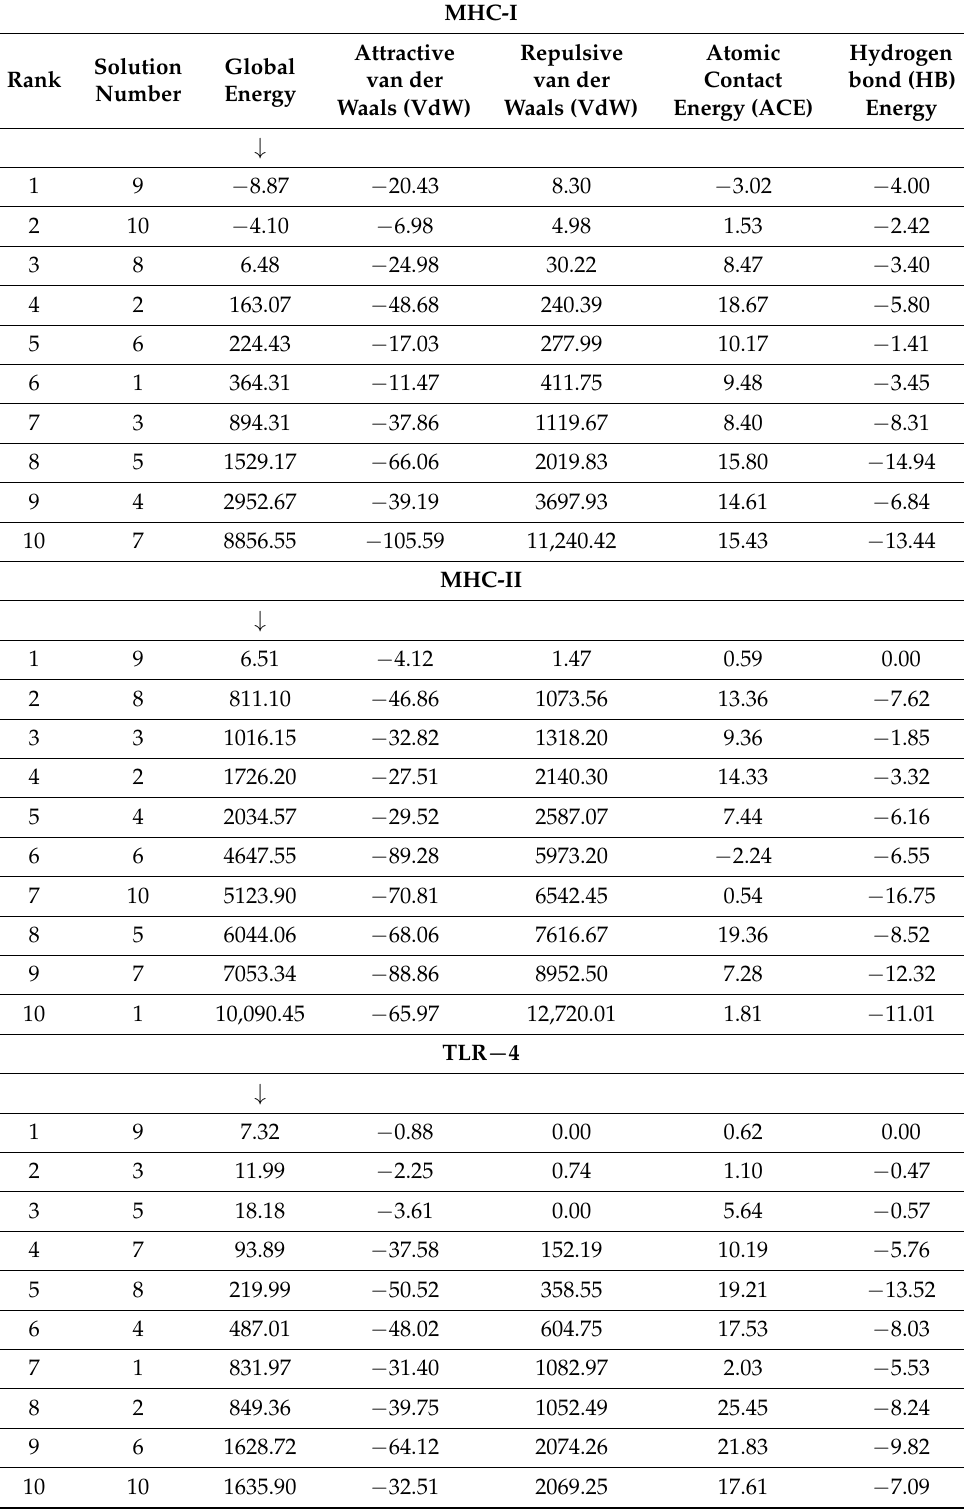
Table 2. Top 10 refined docked complexes of vaccine to MHC-1 generated by FireDock server. Energy is represented in kJ · mol − 1